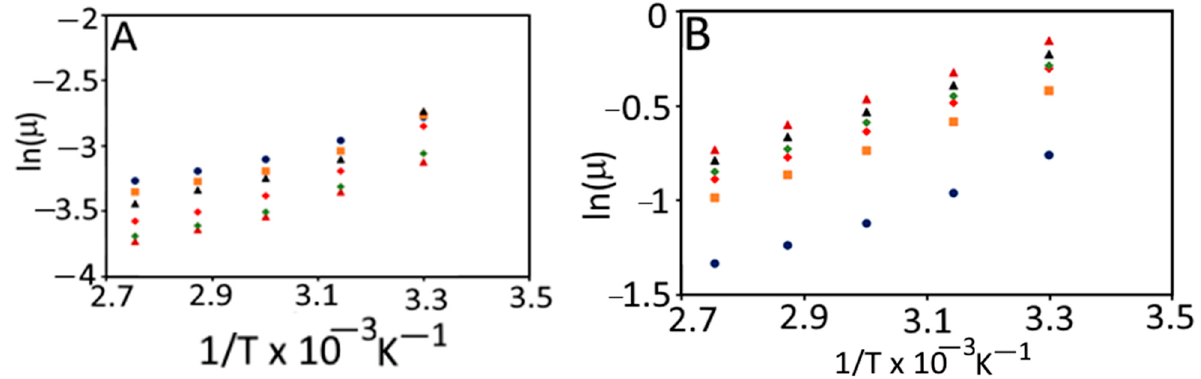
Figure 6. Arrhenius plot for the viscosity of currant tomato pulp ( A ) and paste ( B ). Control ( ), T55 ( ), T65 ( ), T75 ( ), T85 () , and T95 ( ). T55 and T95 represent coded temperature values for cold- and hot-break heat treatments.